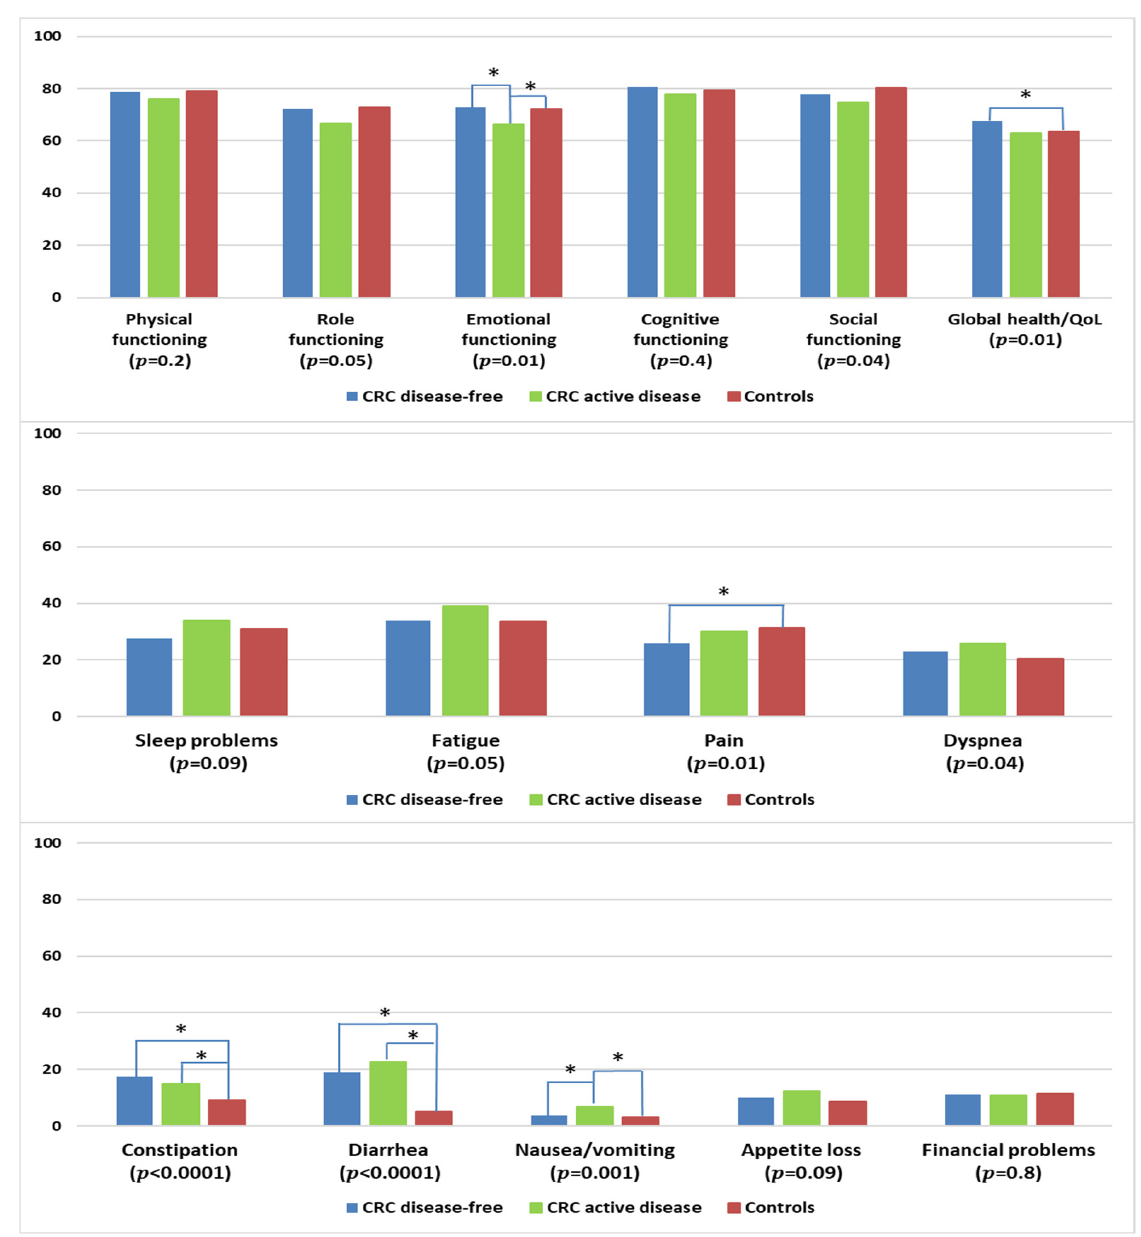
Figure 7. Mean EORTC QLQ-C30 scores of colorectal cancer (CRC) survivors by disease status, and controls. Models are adjusted for age at survey, sex, and education. Disease-free: stage I–III at diagnosis and remaining disease-free at follow-up according to self-report; active disease: stage IV at diagnosis or reported subsequent recurrence, metastasis, or primary cancer. The p -values shown indicate the global comparison between cancer survivors with and without active disease and controls. The line spans and asterisks (*) indicate the subgroups that showed significant differences in pairwise comparison. For example, the line span for global health/QOL is across three columns, indicating that disease-free CRC survivors reported significantly higher global health/QOL when compared with controls. All results are based on 25 imputations of missing values.